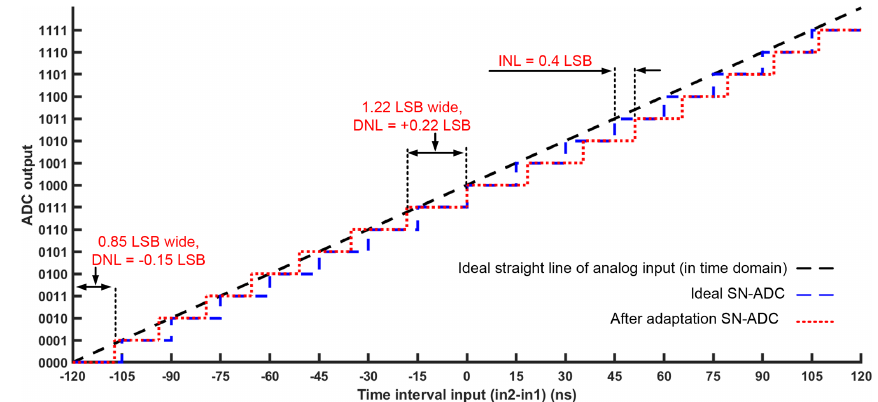
Figure 17. The transfer function of SN-ADC for both ideal and after adaptation at corner no. 5 in Table 3, at the following circuit conditions: V dd is 3V, temperature is 85 ◦ C, and the process corner is the WO (worst-case one). After adaptation, the SN-ADC parameters NOMC, DNL, and INL are no missing code, i.e., 0.22 and 0.4LSB,